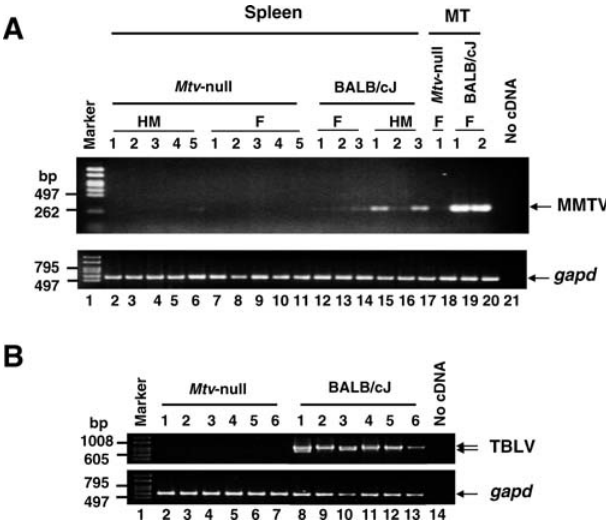
Figure 2. Exogenous MMTV RNA Loads Are Higher in the Presence of Endogenous Mtv Proviruses (A) RT-PCR indicates higher levels of C3H MMTV RNA in spleens derived from infected BALB/c mice compared to those from infected Mtv -null mice. The numbers above each lane represent separate BALB/c or Mtv - null animals as indicated. Mice injected with cloned HYB-MTV-producing cells are designated HM, whereas mice infected by foster-nursing are designated F. Organs were harvested between 6–15 mo post-infection in BALB/c mice at the time of tumor development, whereas organs from Mtv -null mice were harvested between 10–15 mo post-infection. MT, mammary tumor (B) RT-PCR analysis shows lower TBLV levels in Mtv -null versus Mtv - positive strains. Organs were harvested between 4–10 mo post-infection in BALB/c mice at the time of tumor development; organs from Mtv - negative mice were obtained at 10 mo